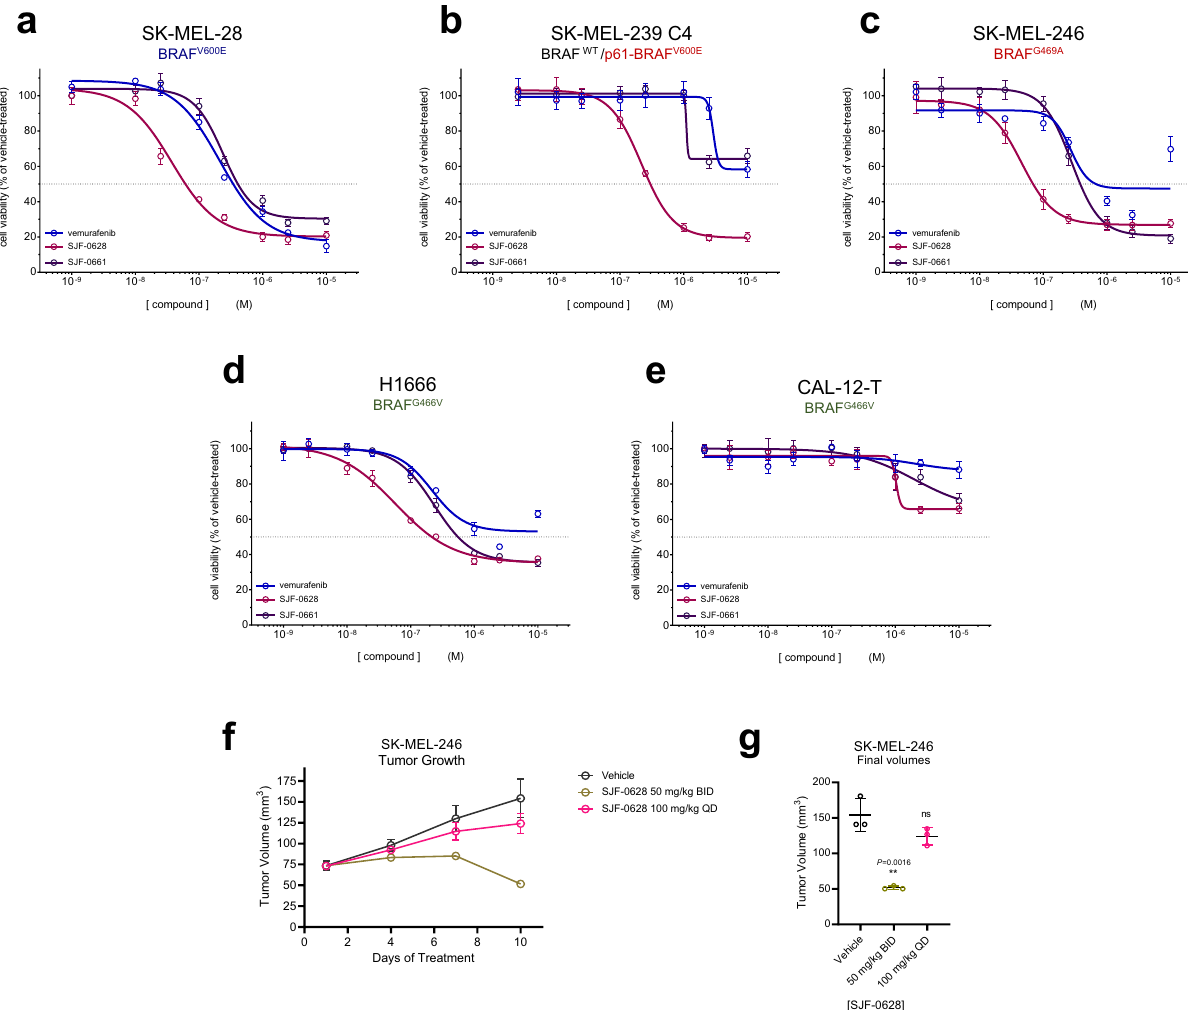
Fig. 4 SJF-0628 outperforms vemurafenib in inhibiting growth of cell lines expressing mutant BRAF. a Cell proliferation assay in SK-MEL-28 cells treated with increasing amounts of vemurafenib, SJF-0628, or SJF-0661 for 3 days (mean ± SD, n = 3 biologically independent samples). EC 50 = 215 ± 1.09 nM, 37 ± 1.2 nM, and 243 ± 1.09 nM, respectively; vemurafenib = blue, SJF-0628 = burgundy, SJF-0661 = purple. b Cell proliferation assay in vemurafenib resistant SK-MEL-239-C4 cells treated with increasing amounts vemurafenib, SJF-0628, or SJF-0661 for 5 days (mean ± SD, n = 3 biologically independent samples); vemurafenib = blue, SJF-0628 = burgundy, SJF-0661 = purple. c Cell proliferation assay in SK-MEL-246 (Class 2) cells treated with increasing amounts vemurafenib, SJF-0628, or SJF-0661 for 5 days (mean ± SD, n = 3 biologically independent samples); vemurafenib = blue, SJF-0628 =